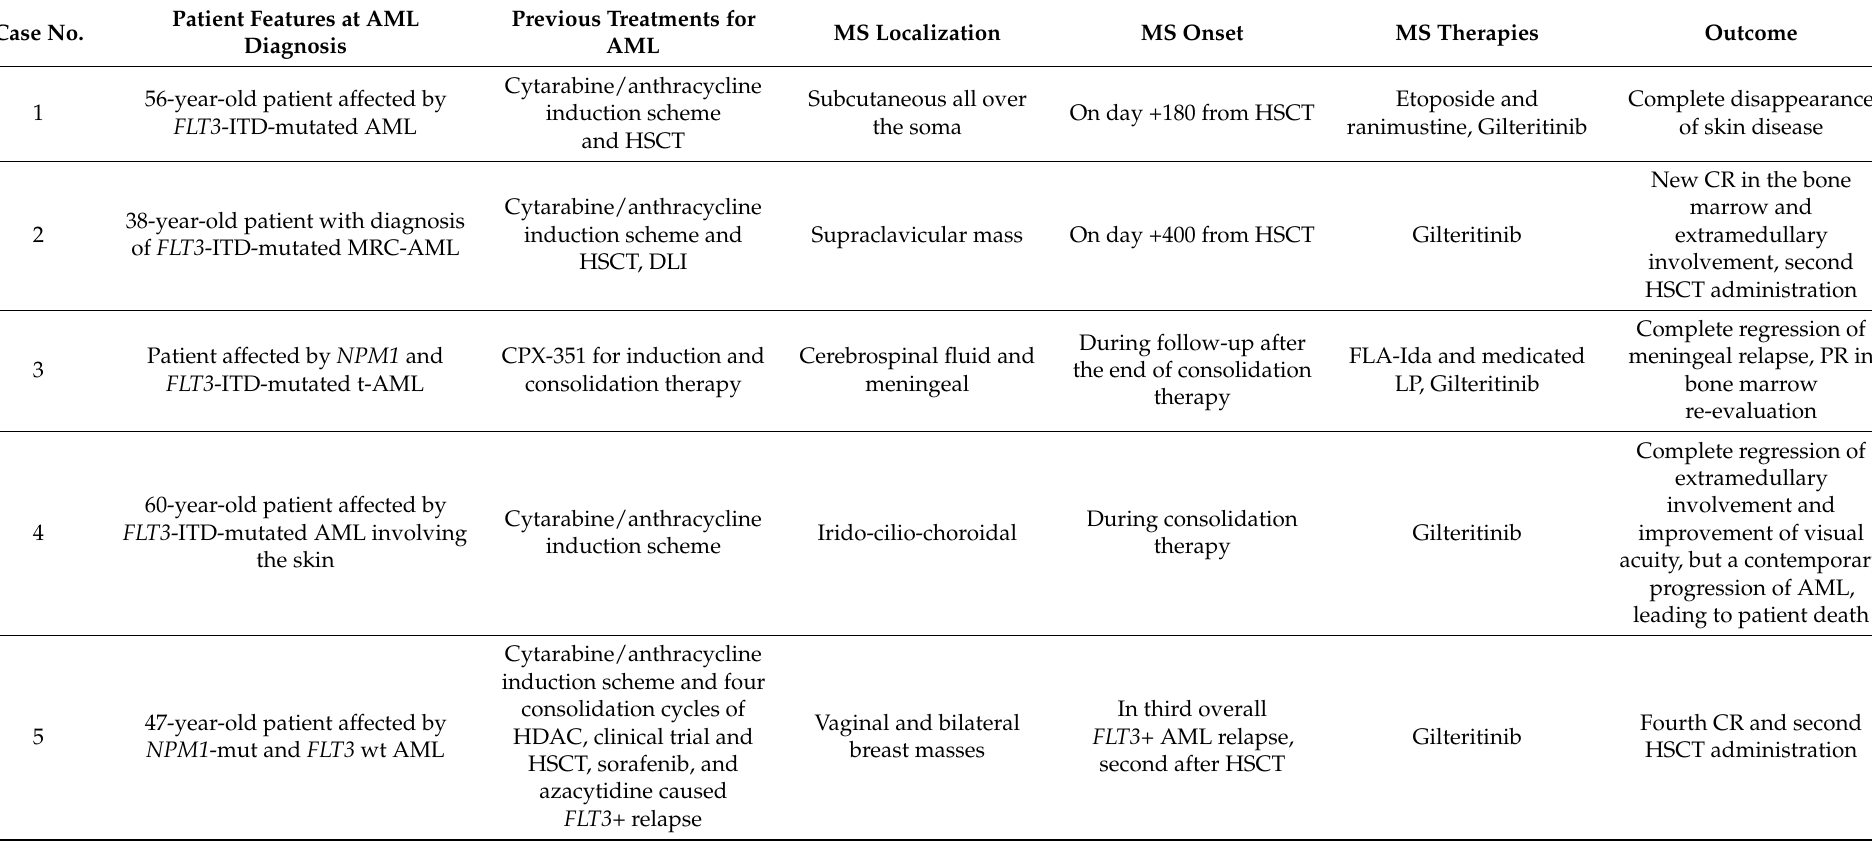
Table 1. Panel of clinical cases reported in the literature treated with gilteritinib, as described in the text. AML = acute myeloid leukemia; MRC-AML = myelody- splasia-related-change AML; t-AML = therapy-related AML; wt = wild type; HSCT = hematopoietic stem cell transplant; DLI = donor lymphocyte infusion; HDAC = high-dose Ara-C; CR = complete remission; PR = partial